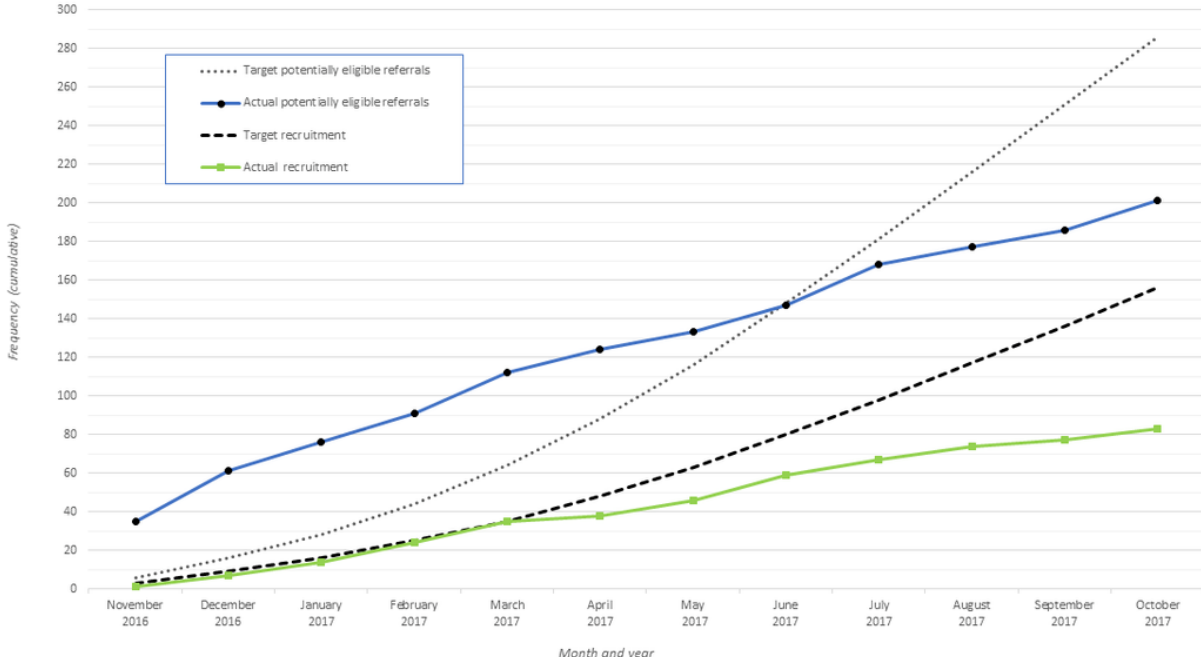
Figure 2. Target versus actual referrals and recruits within the 12-month pilot phase. Note: 6 of the patients who were referred within the pilot phase were recruited later - 5 in November 2017 and 1 in January 2018 (presented in consort, not depicted here as the trial was